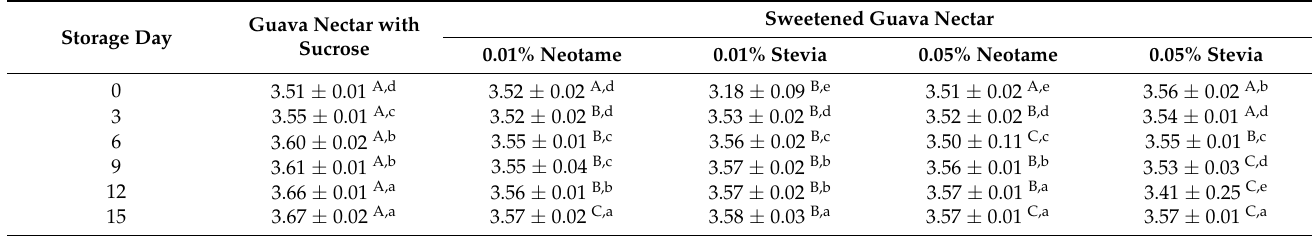
Table 4. The pH of guava nectar and sweetened guava nectar during 15th of storage day at 5 ◦